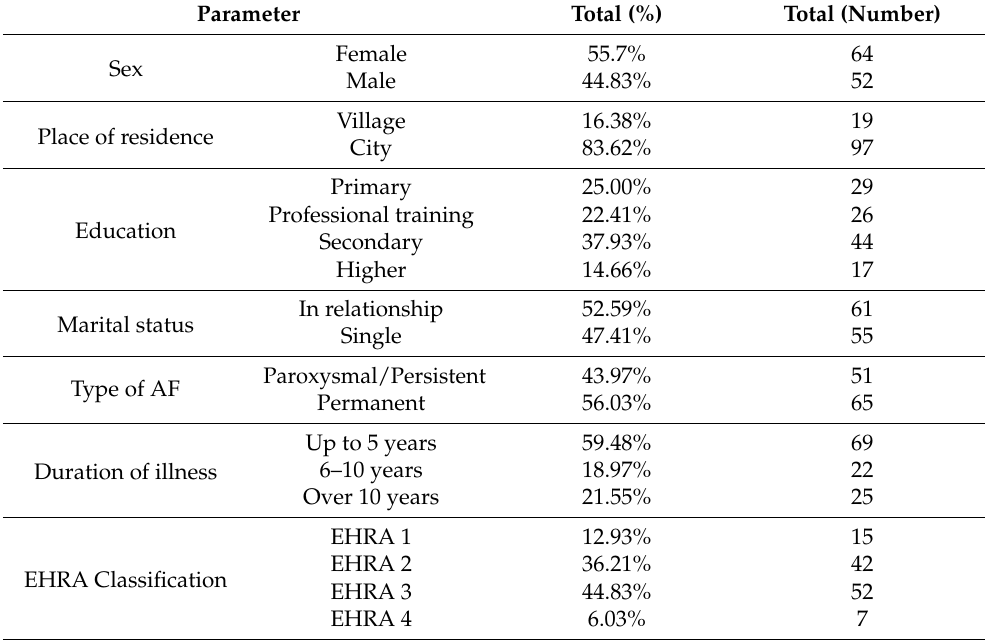
Table 1. Sociodemographic and clinical